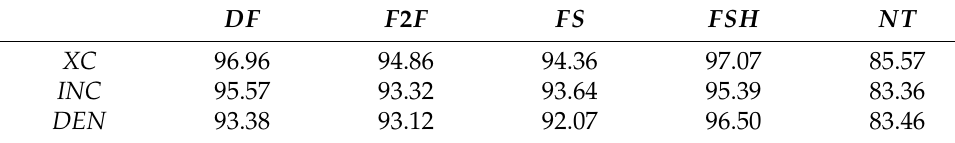
Table 2. Accuracy of networks fine tuned on YouTube